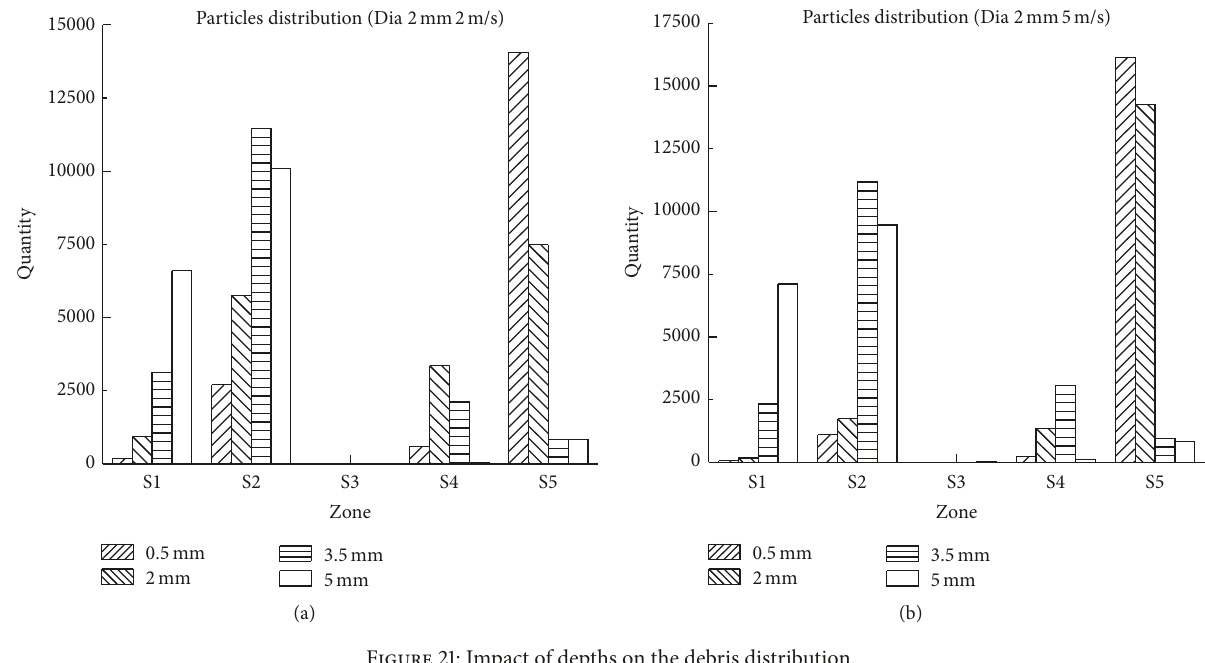
Figure 21: Impact of depths on the debris distribution.